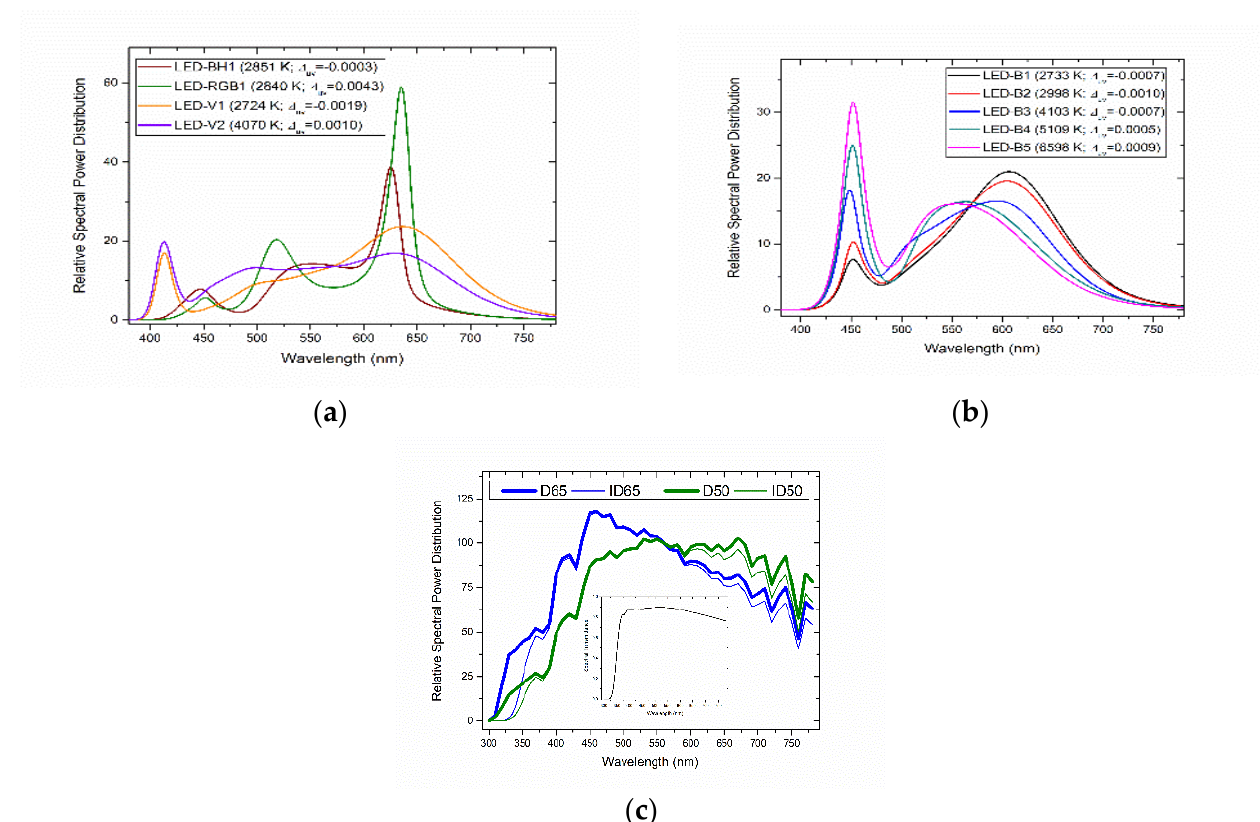
Figure 5. LED illuminants spectral power distribution of ( a ) the SPD, ( b ) the Standards D65 and ( c ) D50 [79].